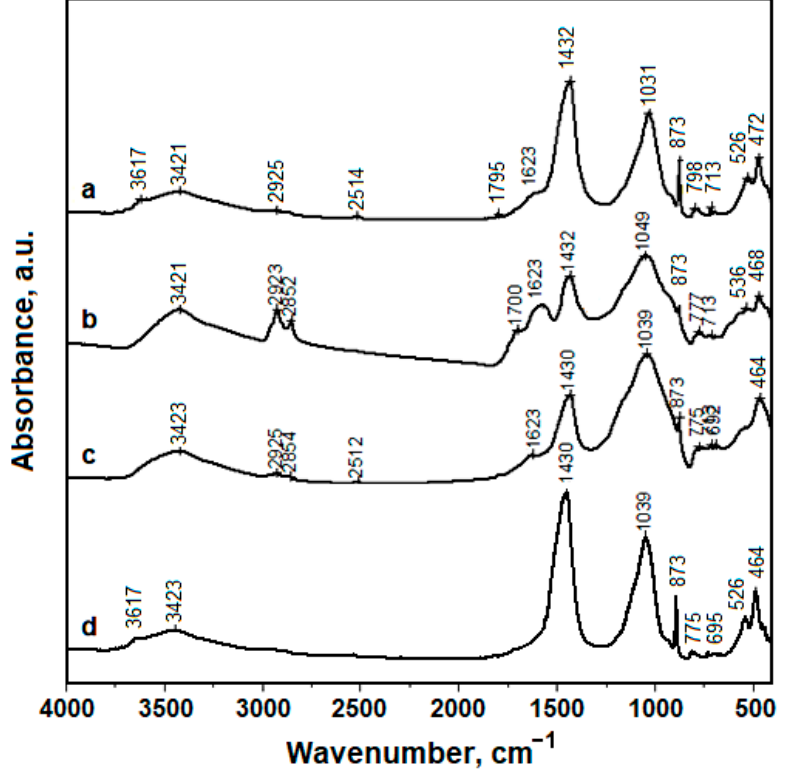
Figure 5. FTIR spectra results in amphora sediments: ( a ) Sample1, ( b ) Sample2, ( c ) Sample 3 and ( d ) resting